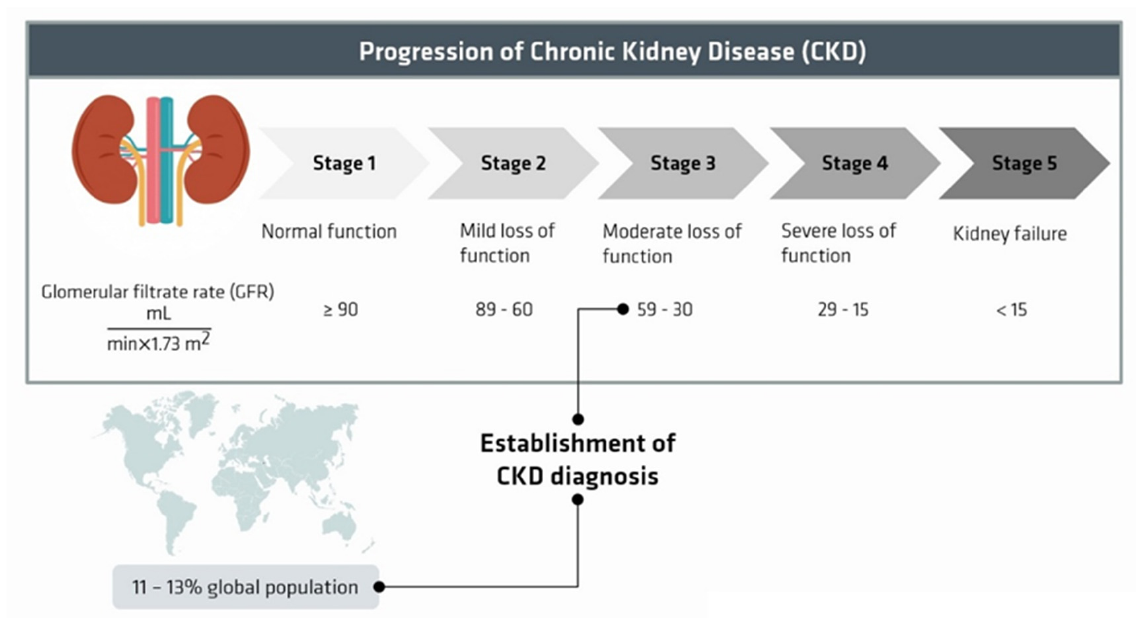
Figure 1. Degrees of decreased kidney function, adapted from [1].